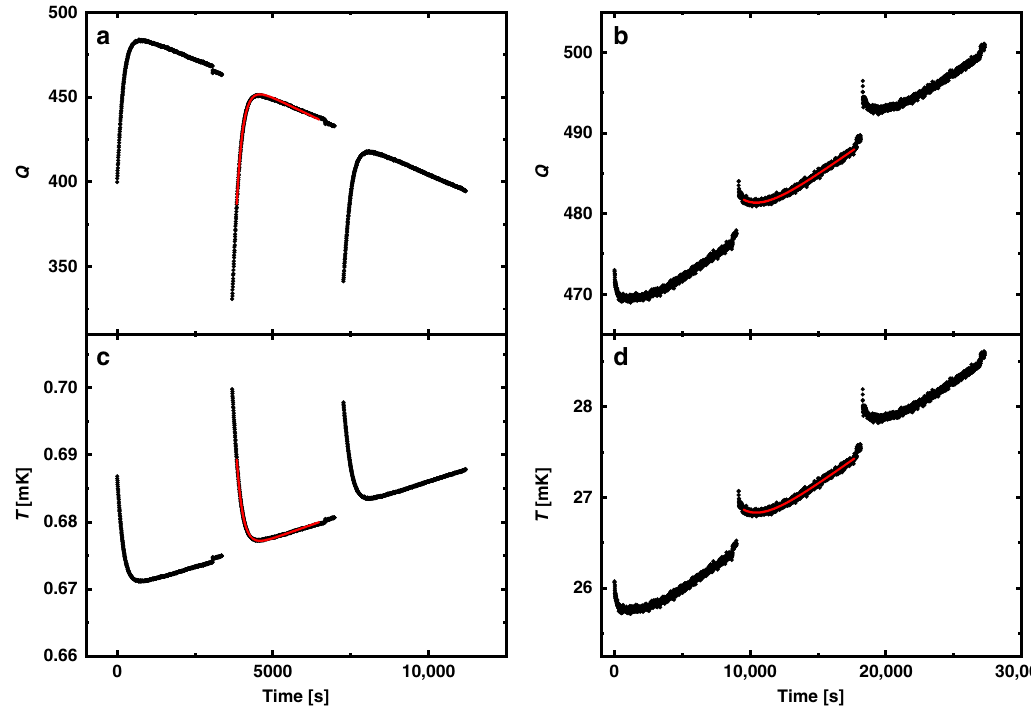
Fig. 2 Heat pulses in normal and super fl uid states. a Typical pulses applied in the super fl uid state recording the Q of the IC fork vs time and b in the normal state at 22 bar. Also shown in red are the fi tted decays to an exponential with additional linear term to account for the steady temperature drift. The Q response is reversed in the normal and super fl uid states, because the viscosity decreases with increased temperature above T T c . c , d The corresponding inferred temperature